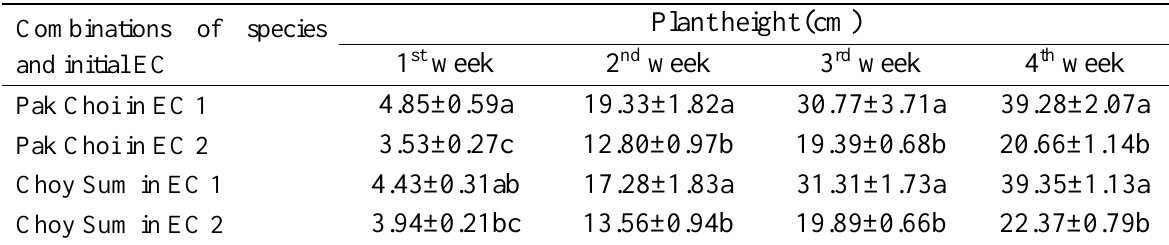
Table 8. Effect of combination of species and initial electrical conductivity on plant height Combinations